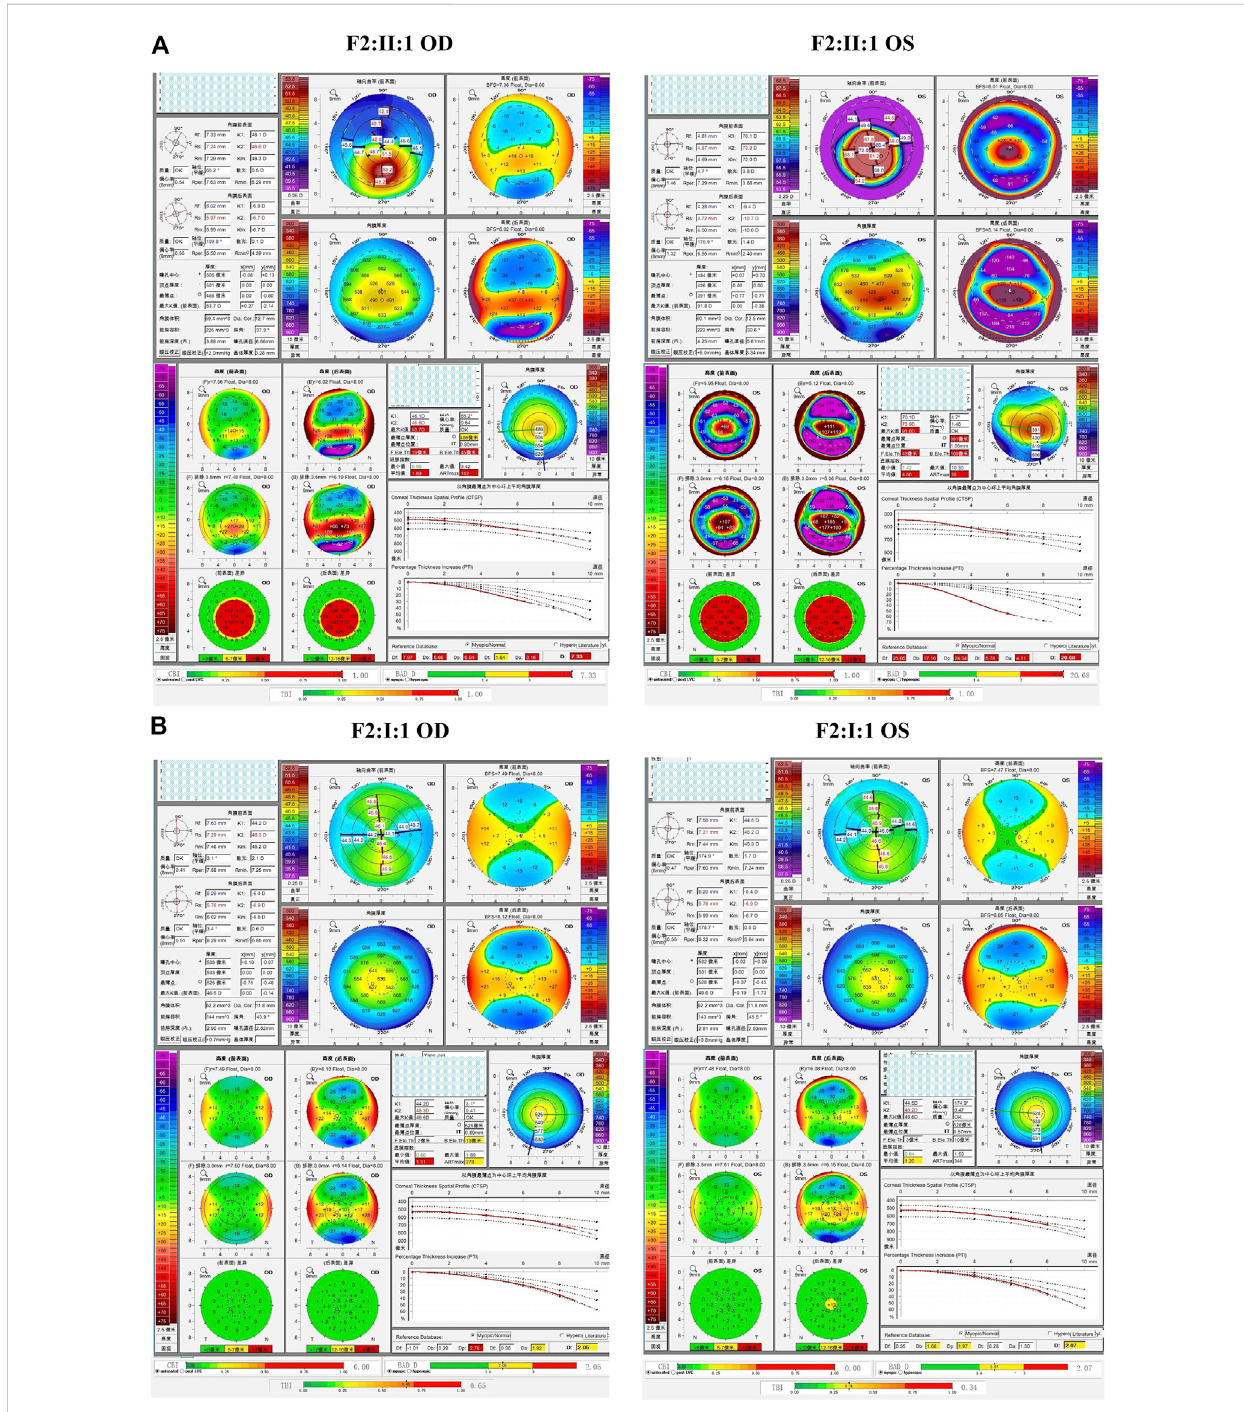
FIGURE 5 Pentacam and Corvis ST images of the proband and asymptomatic fi rst-degree relatives carrying the p.G160V variant in F2. (A) Abnormal corneal topography and biomechanics of the proband. (B) Pentacam and Corvis ST examinations of the father with the p.G160V variant revealed fi ve suspicious parameters(ARTmax,B.Ele.Th,Da,BAD-D,andTBI)andoneabnormalparameters(Dp)intherighteye,while foursuspiciousparameters(Db,Dp,BAD-D and TBI) were detected in the left